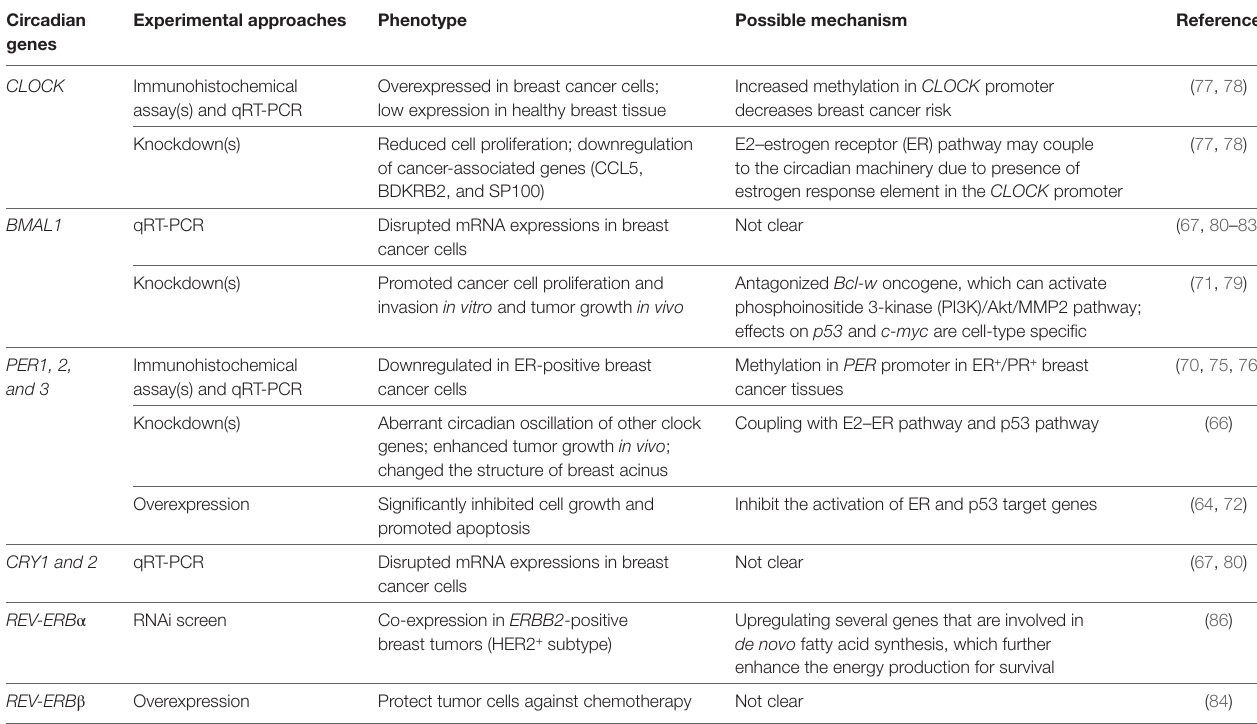
TABLe 1 | Roles of clock genes in breast cancer